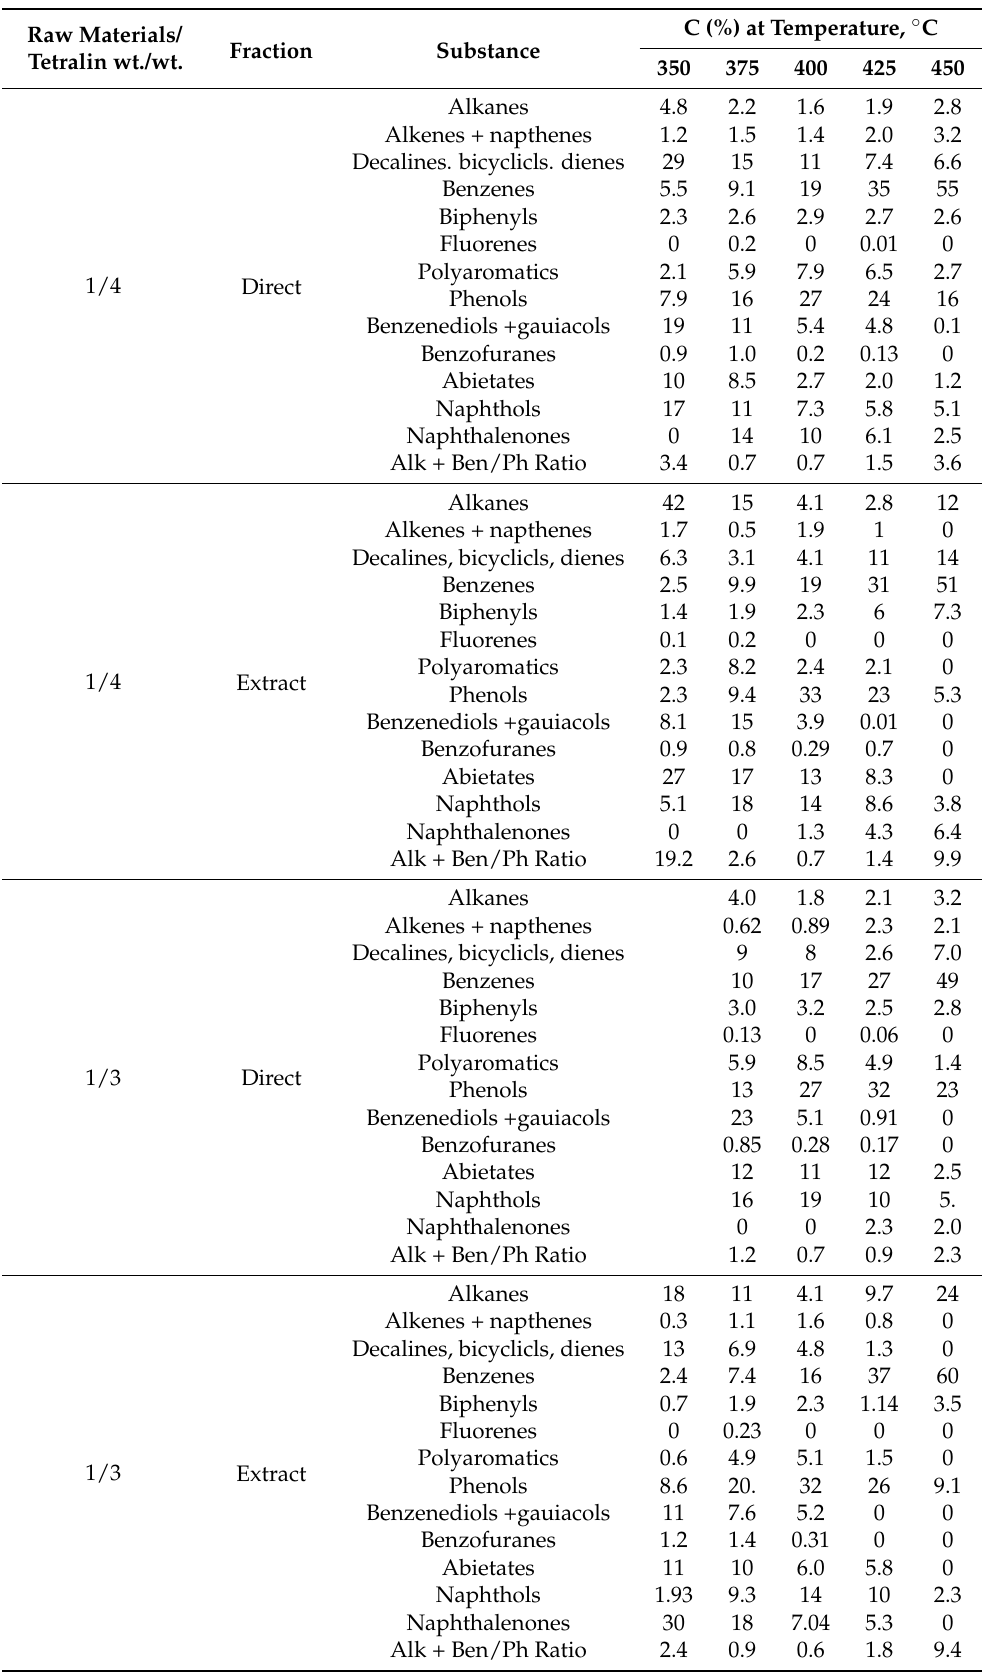
Table 3. Effect of dilution and reaction temperature on the composition of liquid products obtained by thermal dissolution of